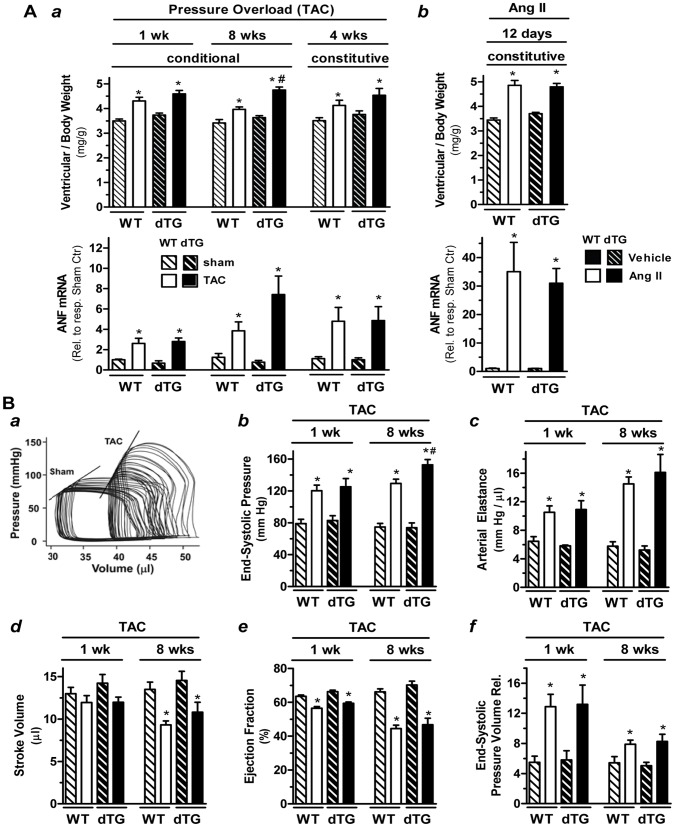
dTG and WT mice have comparable hypertrophic and functional responses to TAC and Ang II.[A] Hypertrophic response to pressure overload (panel a) and Ang II infusion (panel b): Ventricular weight (normalized to body weight, top panel) and ANF mRNA (normalized to 18S and expressed relative to sham controls, bottom panel) in wild-type mice (WT) and double transgenic mice (dTG, L1) with conditional or constitutive RGS2 transgene expression after transverse aortic constriction (TAC, n = 10–18 WT and n = 11–15 dTG) or Ang II infusion (n = 9 each) for indicated durations (solid bars). Animals subjected to sham operation (n = 9–15 WT and n = 7–9 dTG) or vehicle (saline, n = 5–6 each) were used for comparison (cross-hatched bars). ANF expression was assessed at least in half of the animals in each group. * P<0.05 TAC vs sham (a) or Ang II vs vehicle (b); # P<0.05 dTG vs WT. [B] In vivo
 hemodynamic assessment of left ventricular function: (a) Representative pressure volume (PV) recordings during preload reduction via inferior vena cava compression in WT mice that had been subjected to TAC or sham operation 4 wks earlier. The traces show raw data before subtraction of volume from parallel conduction. The solid lines indicate end-systolic pressure volume relationship (ESPVR). (b) Group data obtained from PV loop analyses for indicated parameters in WT and dTG mice with conditional RGS2 expression (L1) after TAC for 1 wk (n = 11 WT and n = 8 dTG) or 8 wks (n = 13–15 WT and n = 8–9 dTG) compared to respective sham controls (1 wk: n = 9 WT and n = 5 dTG; 8 wks: n = 7–8 WT and n = 5–6 dTG). * P<0.05 TAC vs Sham; # P<0.05 dTG vs wt.